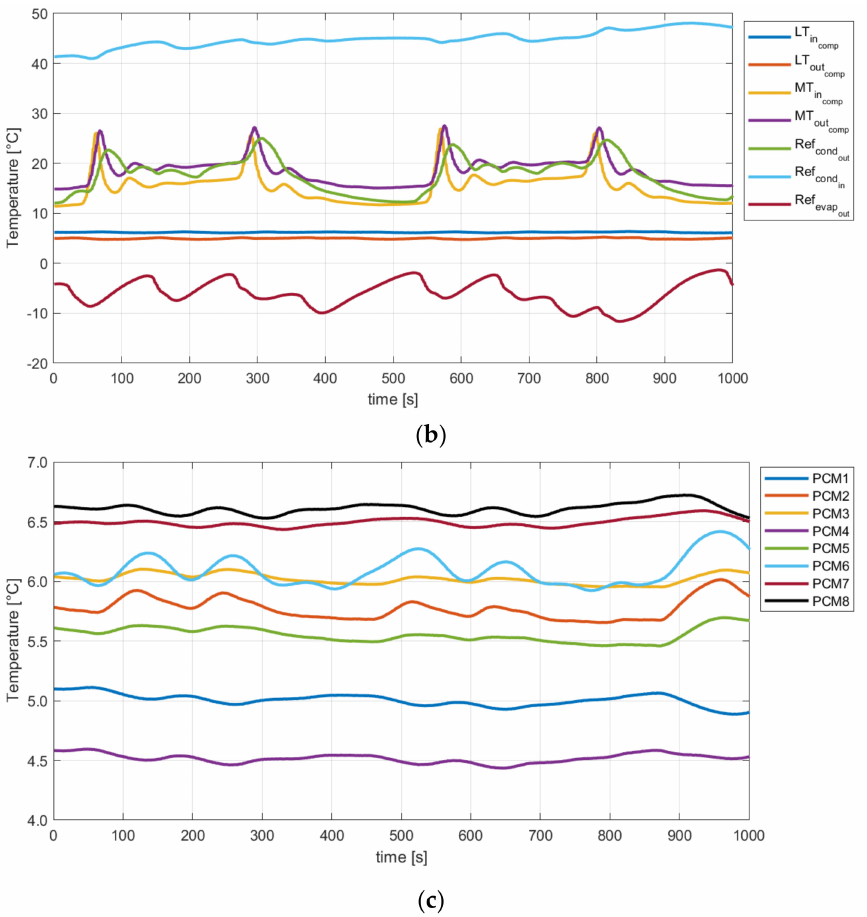
Figure 10. Example of test results for cooling mode 5. ( a ) Temperatures of HTF in the sorption unit; ( b ) temperatures of HTF and R410a in the compression unit; ( c ) temperatures of